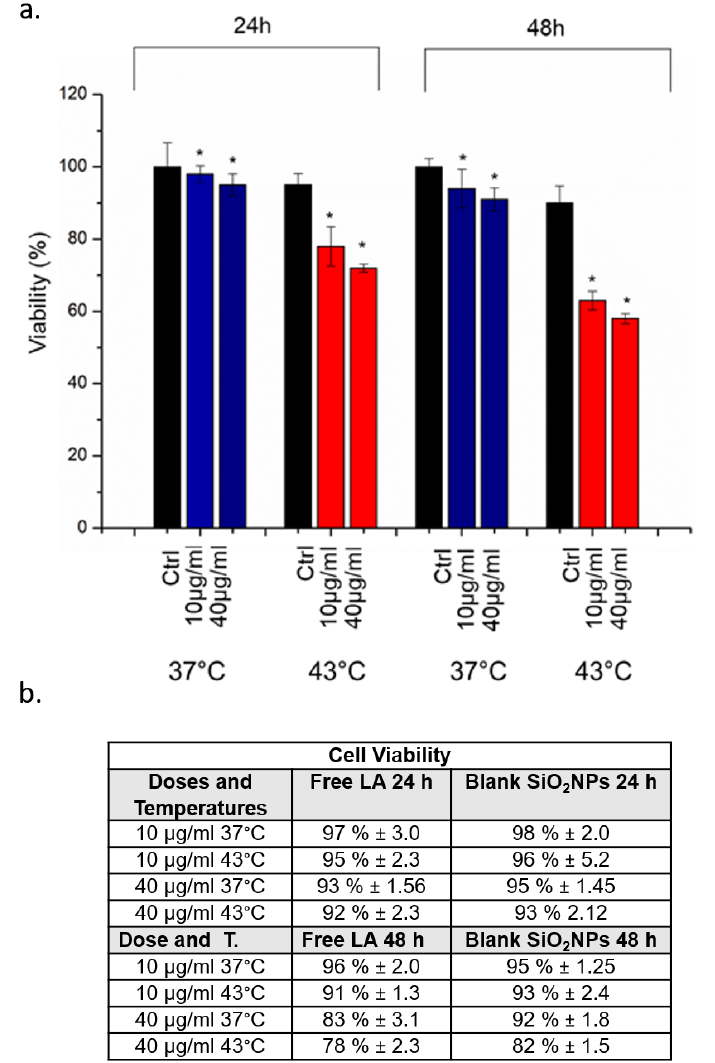
Figure 5. ( a )Viability assay (WST-8) of MCF-7 cells after 24 h and 48 h exposure to 10 µg/mL and 40 µg/mL of SiO 2 @LA NPs at 37 °C and 43 °C. Percent viability of NP-treated cells was expressed relative to non-treated control cells (without SiO 2 @LA NPs exposure). As positive control (P), cells were incubated with 5% DMSO showing a ~ 60% viability decrease (data not shown). Data reported as mean ± SD from three independent experiments are considered statistically significant compared with control ( n = 8) for p value ˂ 0.05 (<0.05 *). ( b ) Viability values expressed in percentages obtained on MCF-7 cells after 24 h and 48 h exposure to 10 µg/mL and 40 µg/mL of blank SiO 2 NPs and free LA at 37 °C and 43 °C.